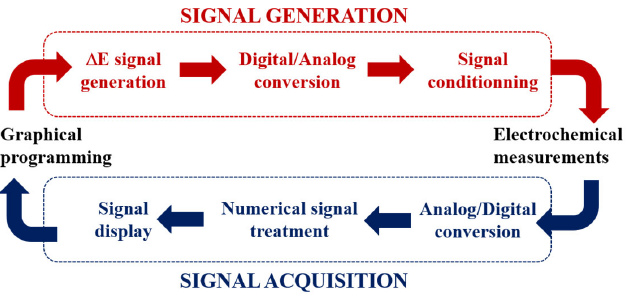
Figure 3. Overall principle of the homemade electrochemical platform composition.